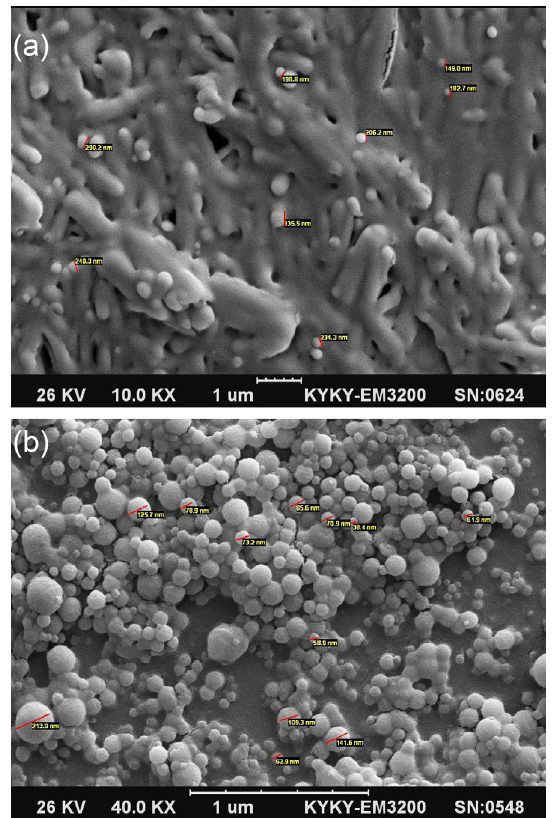
FIGURE 2 - Scanning electron microscopy pictures of ampicillin solid lipid nanoparticles after freeze-drying (a), before freeze- drying in primary preparation (b).